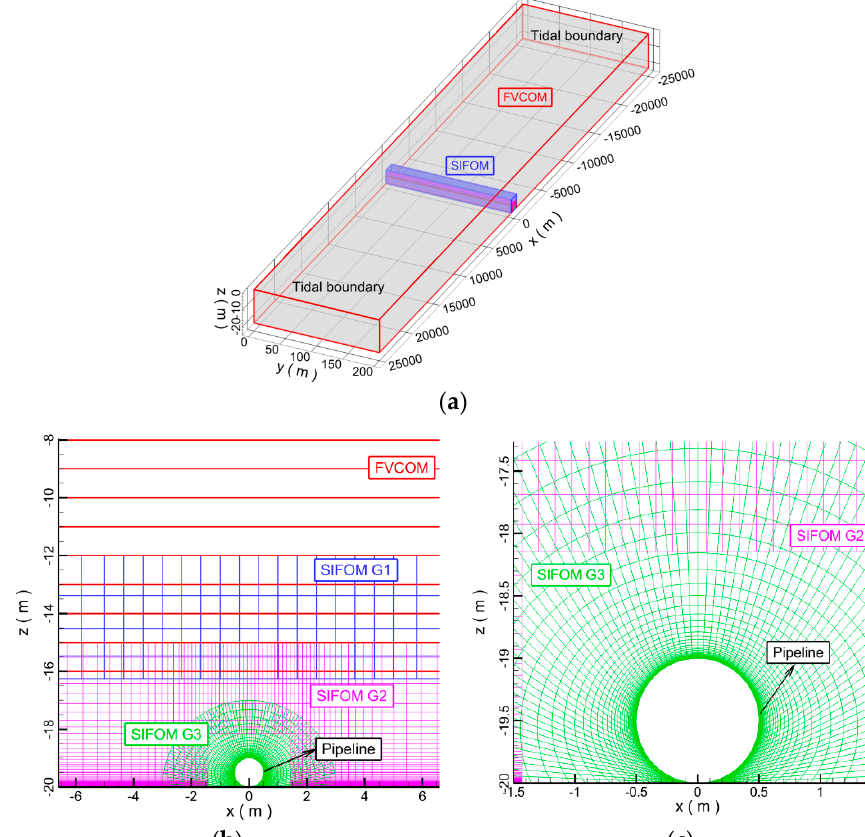
Figure 9. The model setup. ( a ) Computational domain. ( b ) Grids. ( c ) The mesh closing to pipeline.